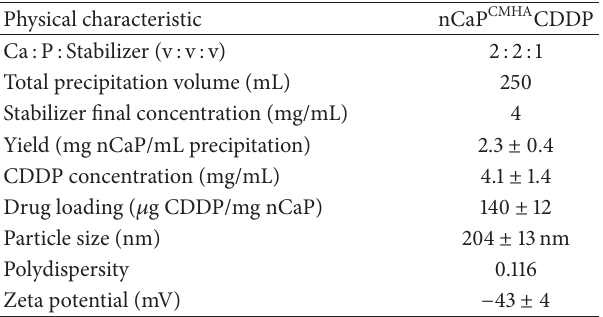
Table 1: Average physical characteristics of nCaP CMHA CDDP. Ratio of components, precipitation volume, and stabilizer final concentra- tion remained the same from batch to batch. Yield, CDDP concen- tration, drug loading, particle size, polydispersity, and zeta potential represent averages and standard deviations from a minimum of three